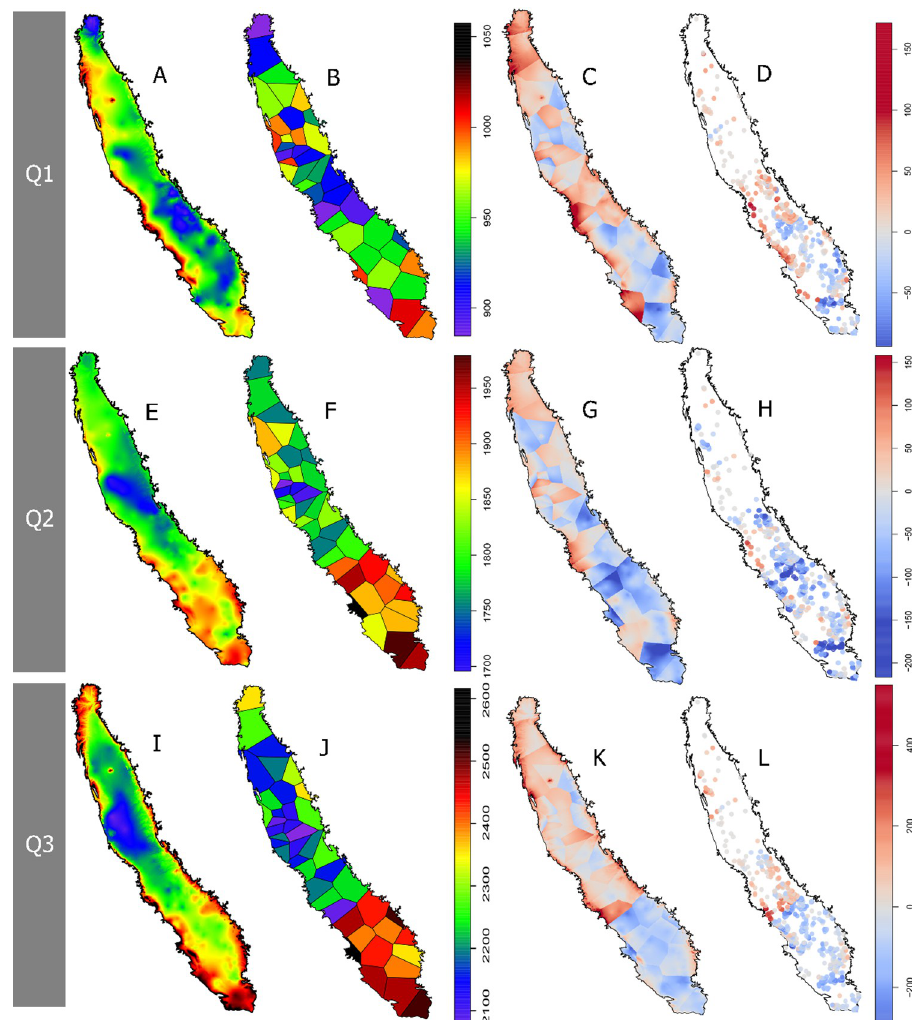
Fig 3. GDD Tb0 accumulation interpolated using CIMIS and 731 in-orchard stations (A,E,I), GDD Tb0 accumulation for the closest CIMIS station (B,F,J), discrepancy between interpolation and closest CIMIS (in-orchard/CIMIS interpolation minus closest CIMIS value; C,G,K) and discrepancy between each of the 731 in-orchard stations and their closest CIMIS station (in-orchard minus CIMIS value) (DHL) during the first (Q1; A,B,C,D), second (Q2; E,F,G, H) and third (Q3, I, J, K, L) quarter of